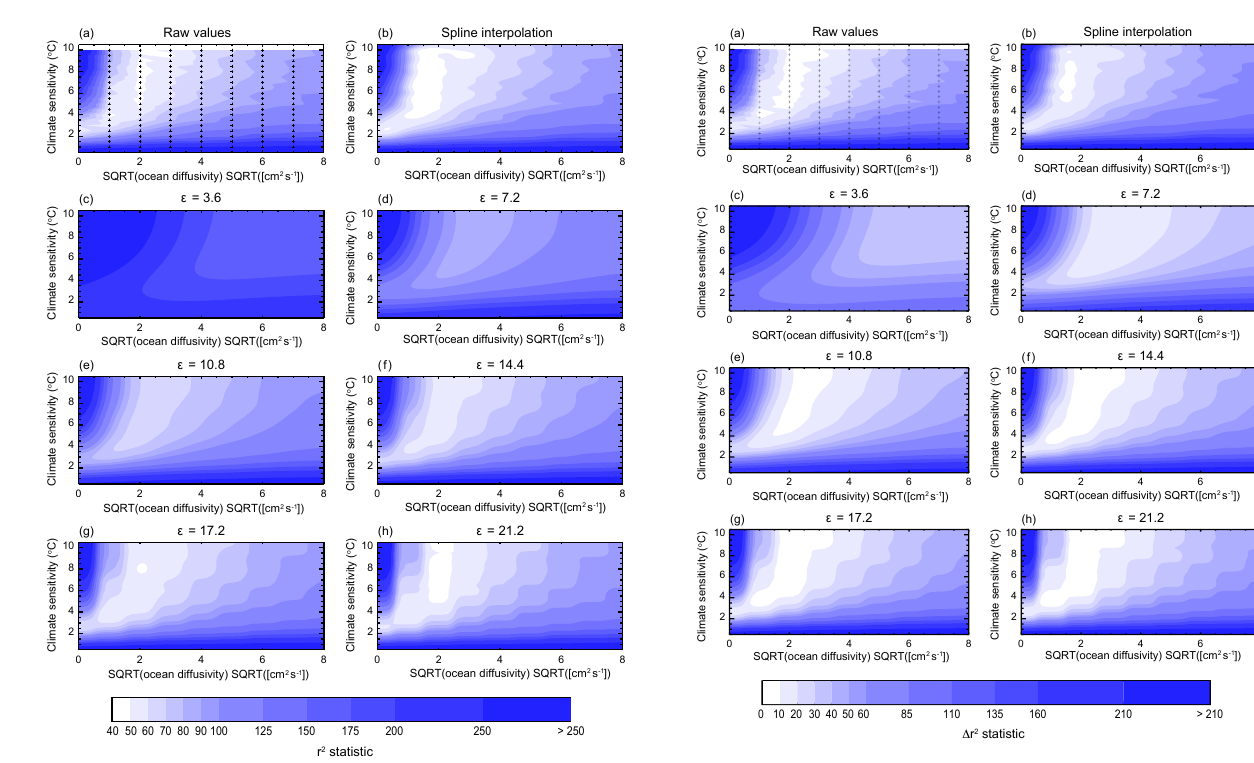
Figure 3. Example of the differences between the algorithms to interpolate goodness-of-fit statistics from the coarse grid of model runs to the finer grid used for the derivation of parameter distribu- tions. Calculated r 2 values (a) are shown along with the interpolated values using the algorithm from Libardoni and Forest (2011) (b) and the radial basis function interpolation with six different values of (cid:15) (c–h) . Node points (+) are indicated in (a) , while the interpolated grid has been omitted for clarity (b–h) .